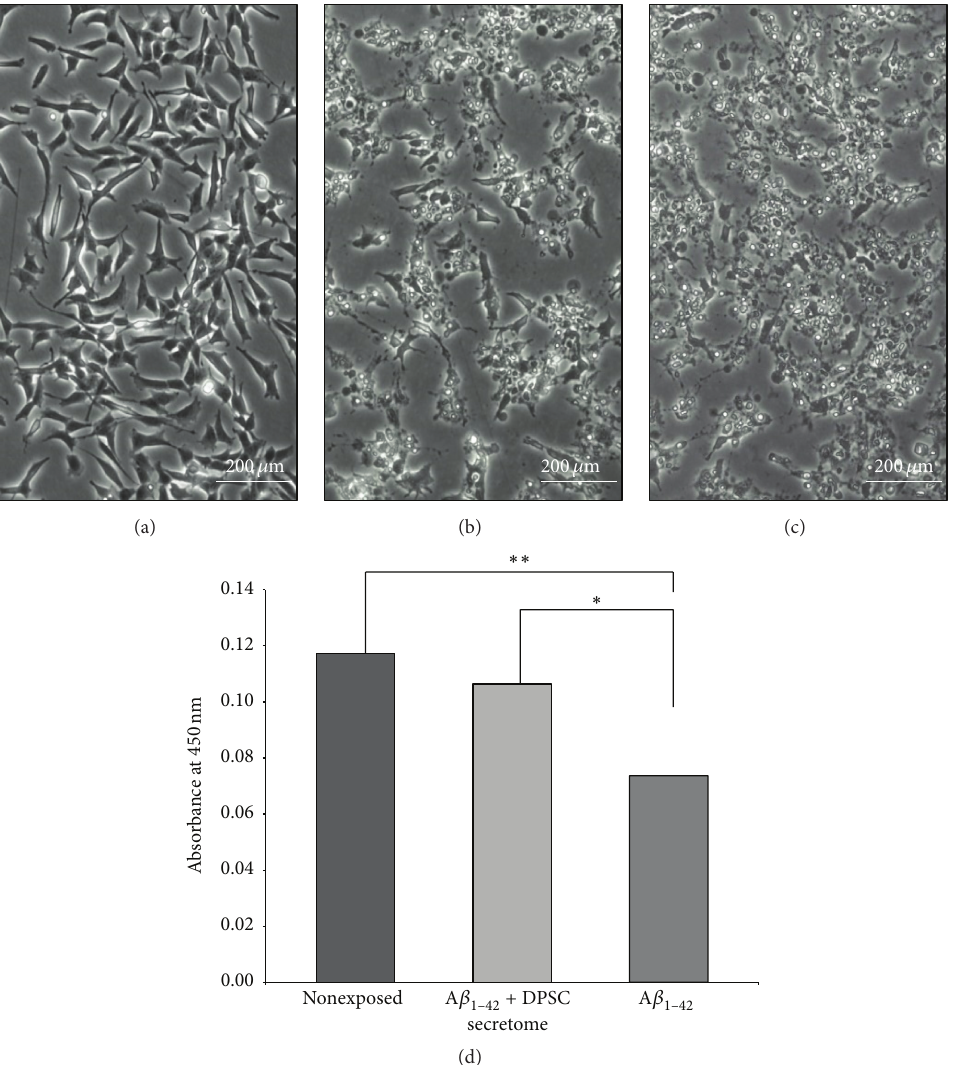
Figure 3: DPSC secretome treatment preserves morphology and improves the viability of SH-SY5Y cells exposed to A 𝛽 1 contrast micrographs of SH-SY5Y cells exposed to A 𝛽 1 presented in Supplementary Figure S1). (d) Cell viability as detected at 450 nm absorbance (mean ± SE, 𝑛 = 3 . ∗ 𝑝 < 0.05 , ∗∗ 𝑝 < 0.01